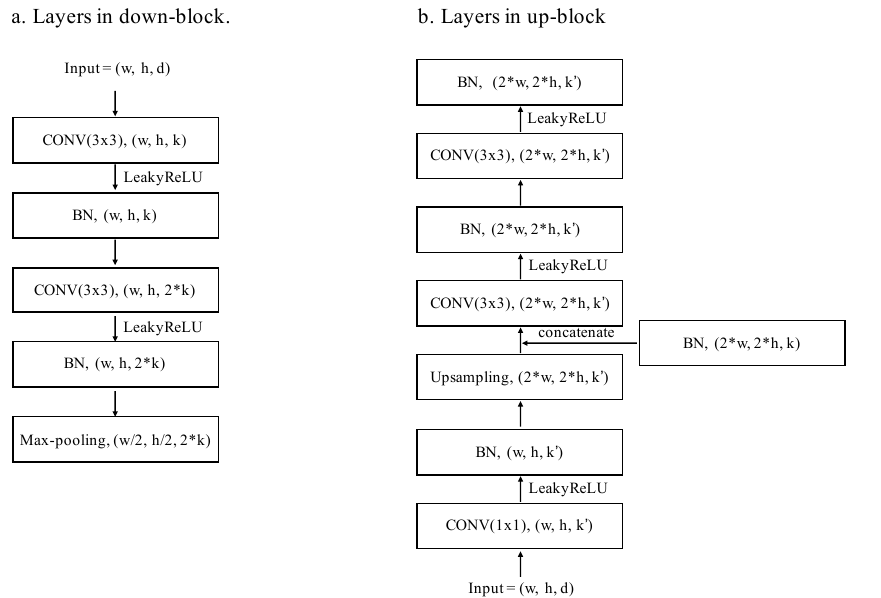
Figure 4. Layers in down-blocks and up-blocks of the shared